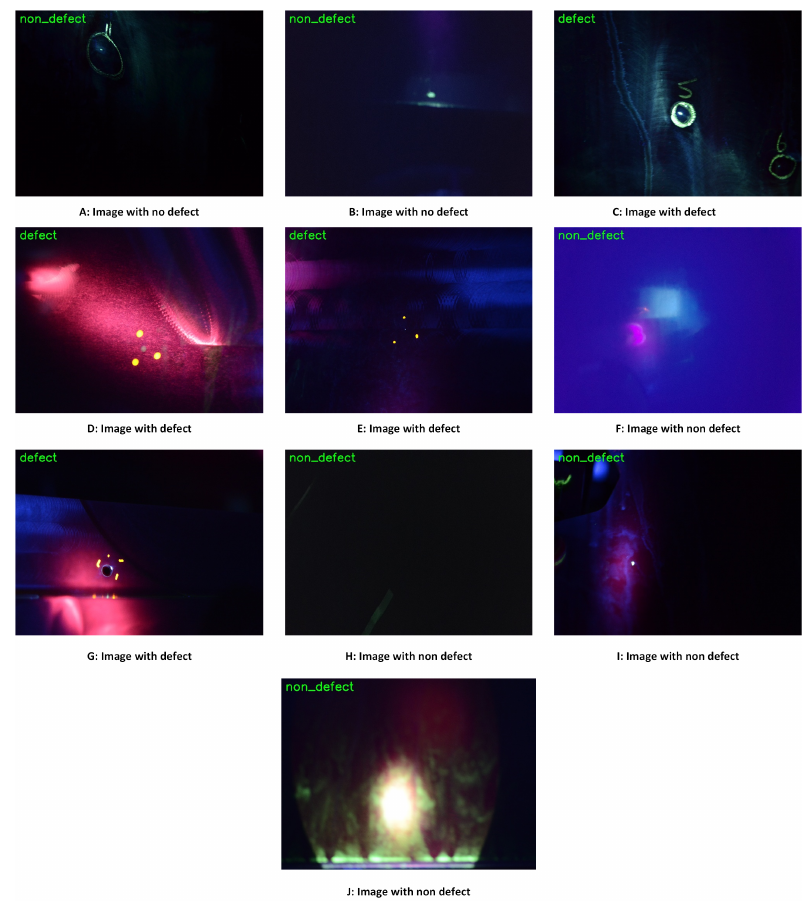
Figure 13. Results of the Random Forest algorithm. ( A – J ) titles are the class were the image actually belongs and the green title on the image is the outcome of the Random Forest